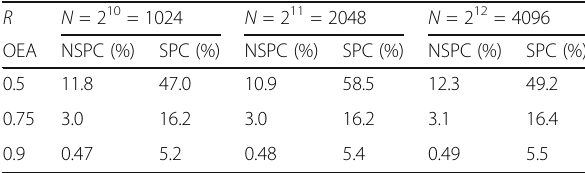
Table 3 Percentages of zero elements in the transformed matrix for our OEA